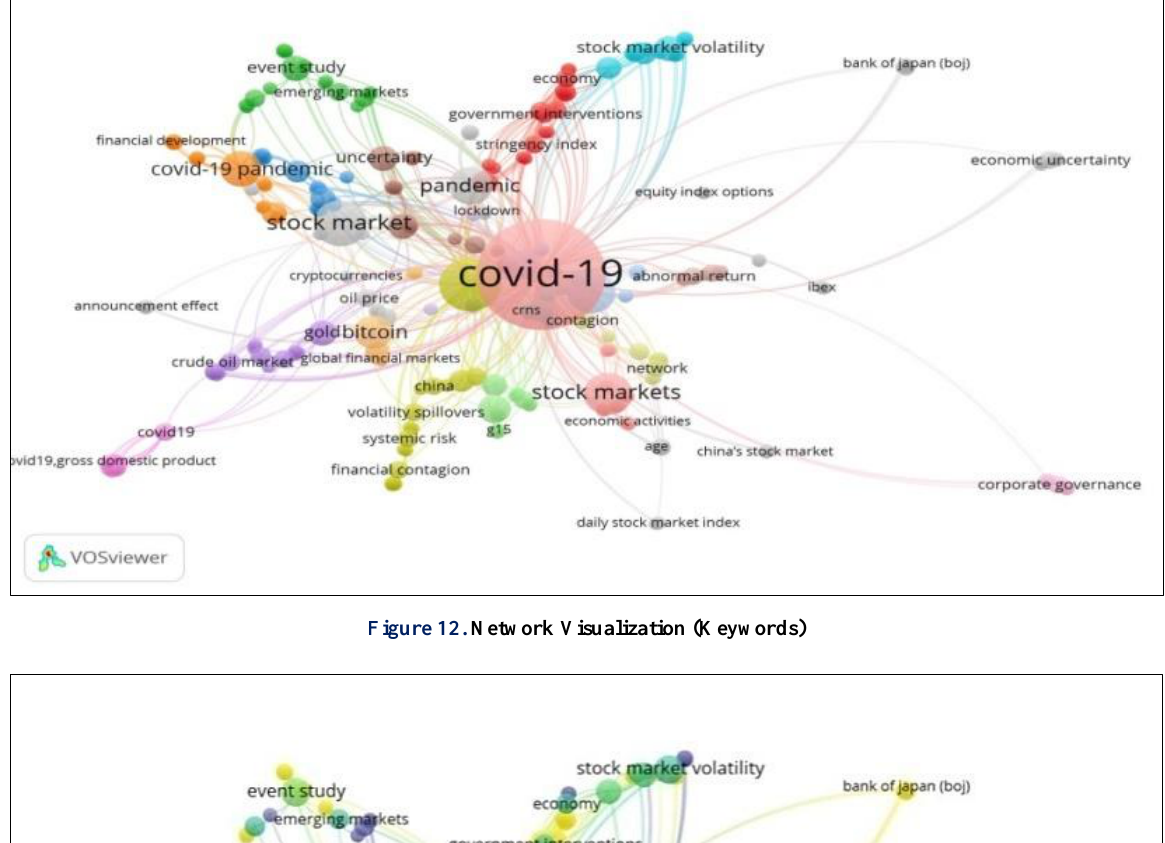
Figure 12. Network Visualization (Keywords)